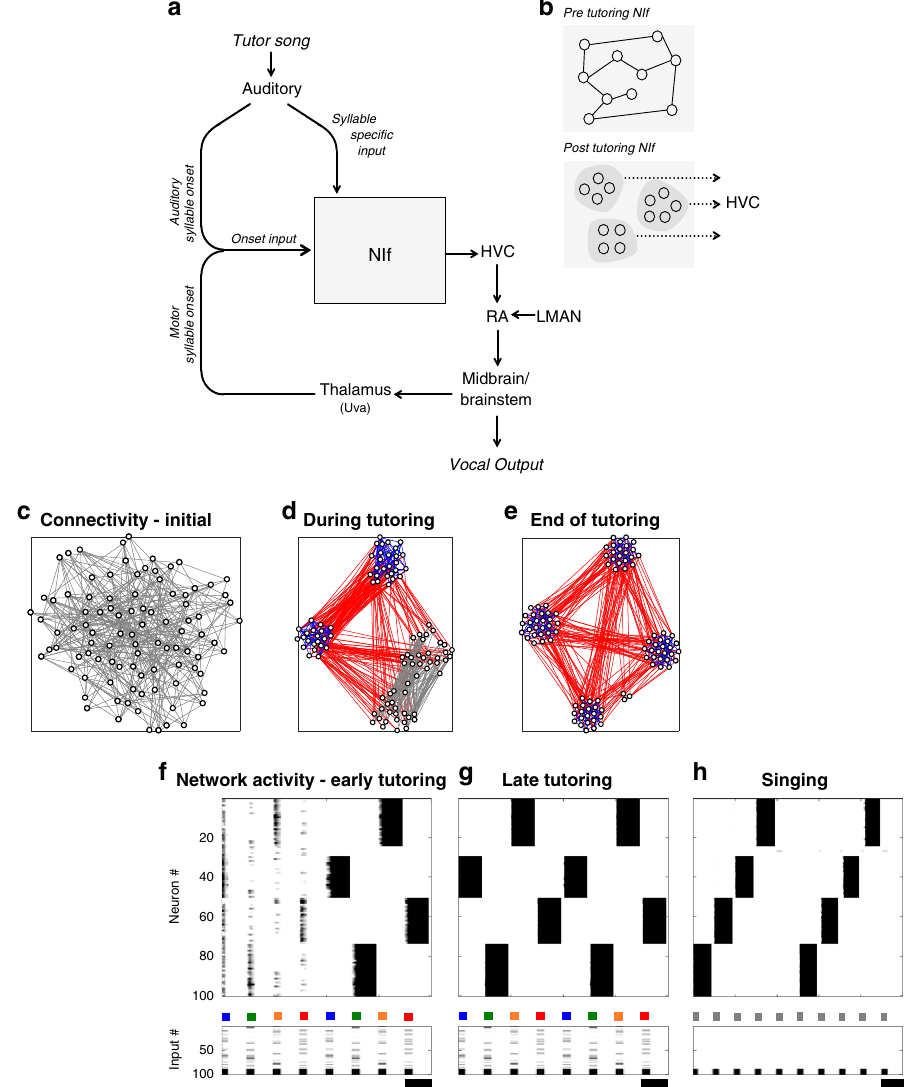
Fig. 7 A neural network model for imprinting and reading out syllable-speci fi c ensembles in NIf. a Schematic of model showing NIf inputs and outputs. During tutoring, inputs include syllable-onset and syllable-speci fi c signals that drive the formation of syllable-speci fi c ensembles. During babbling, syllable- onset input, from an efference copy of vocal/respiratory commands, reactivates stored syllable ensembles. Reactivated NIf ensembles then seed the development of syllable-speci fi c motor sequences in HVC (see Fig. 8). b Illustration of ensemble formation in NIf. Top: initial state, in which recurrent weights are random. Bottom: fi nal state (after tutoring), in which recurrent weights produce self-reinforcing, but mutually inhibitory, ensembles. c – e Network connectivity at three stages of learning, displayed as a t-SNE embedding. Each point represents a neuron, and each line represents a connection between neurons. Weak connections are gray; excitatory connections are blue; inhibitory connections are red. For clarity, only the two strongest excitatory and inhibitory connections into each neuron are displayed. c Initial random connectivity, d Connectivity after early tutoring with four distinct syllables. e Connectivity at the end of tutoring. f – g Plots of network activity during tutoring. The NIf network activity is shown at top, sorted so that ensembles appear as solid blocks; inputs are shown below, with colored bars indicating different syllables. Early in tutoring f , NIf activity is relatively disorganized, but ensembles form quickly. Later in tutoring g , network activity has organized into four distinct ensembles selective for each tutor syllable. During singing h , NIf ensembles are reactivated sequentially (gray bars indicate no syllable-speci fi c